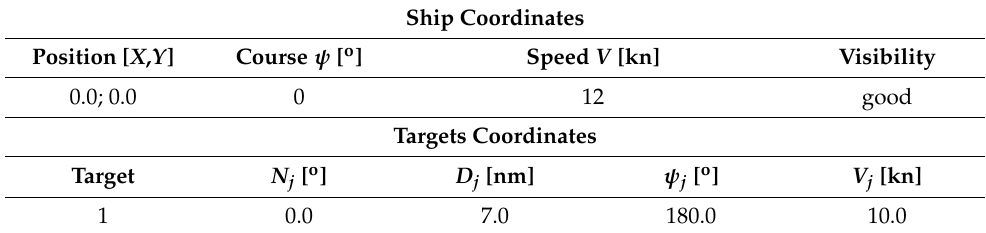
Table 1. Ship coordinates and targets coordinates (one target).